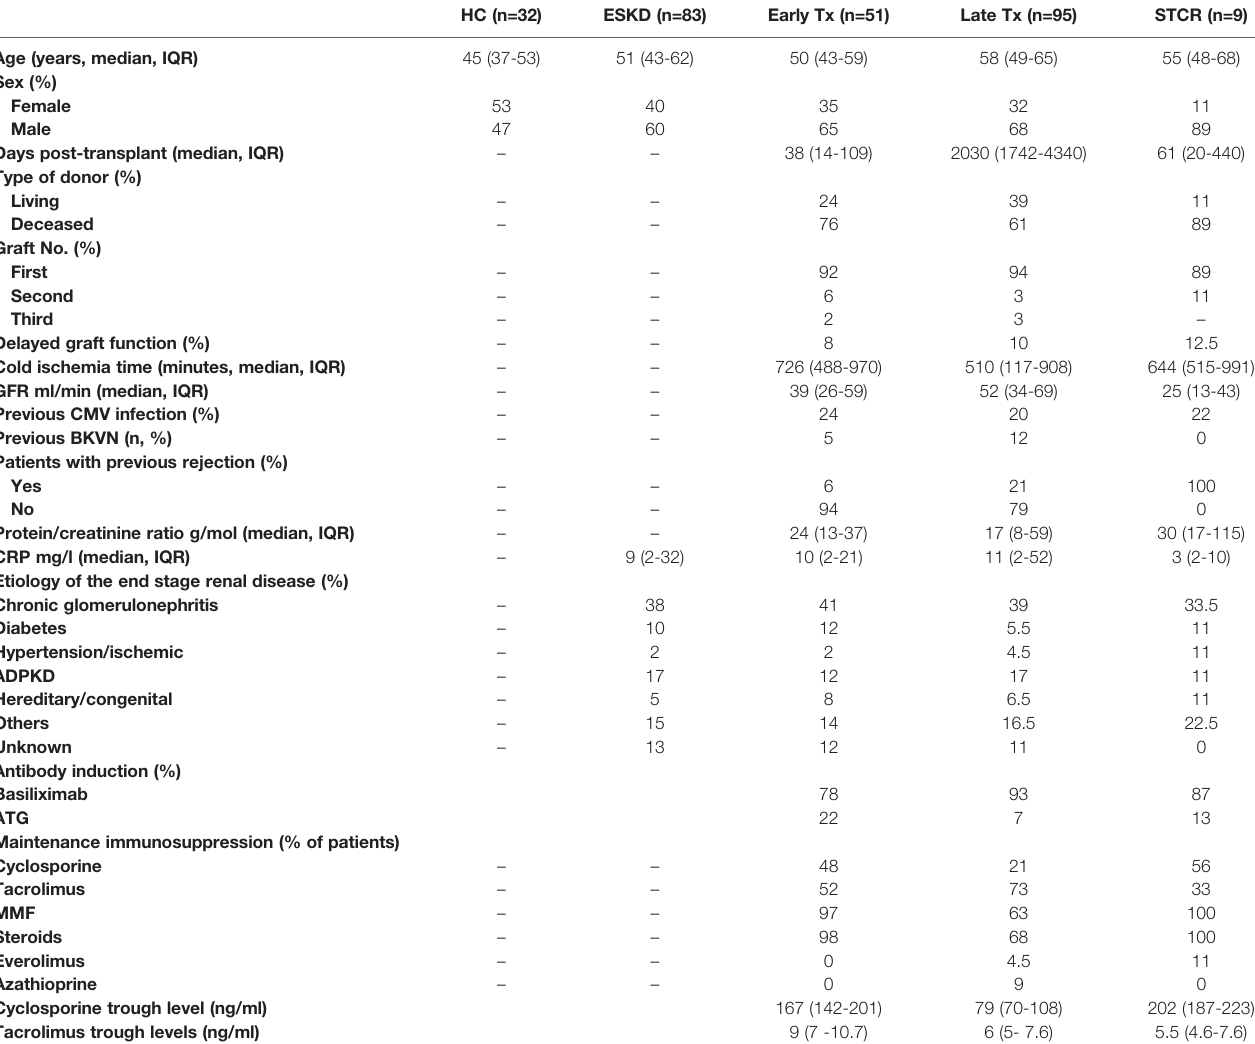
TABLE 1 | Demographic data of healthy controls (HC), end-stage renal disease patients (ESKD), early renal transplant recipients (Tx), late renal transplant recipients, and steroid-treated renal transplant patients with acute cellular rejection